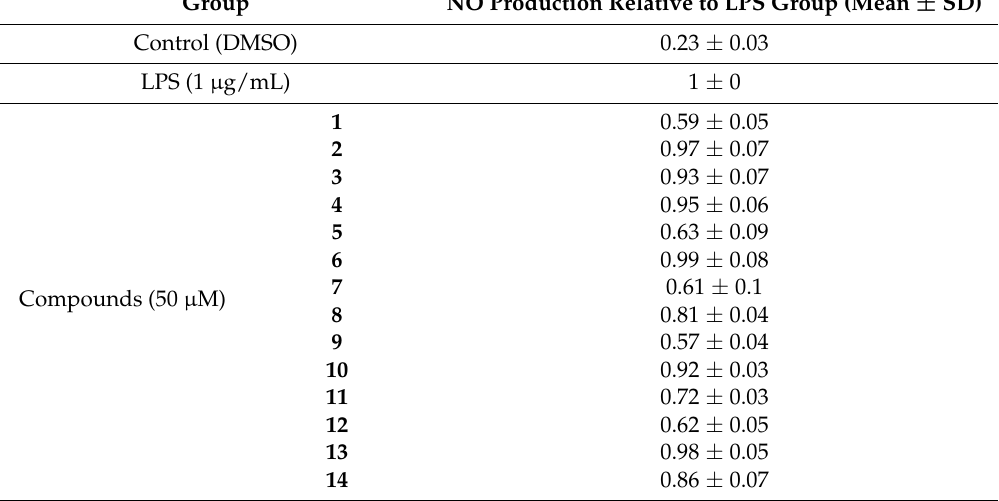
Table 1. The NO production relative to LPS group of isolated compounds in LPS-stimulated RAW 264.7 macrophages.